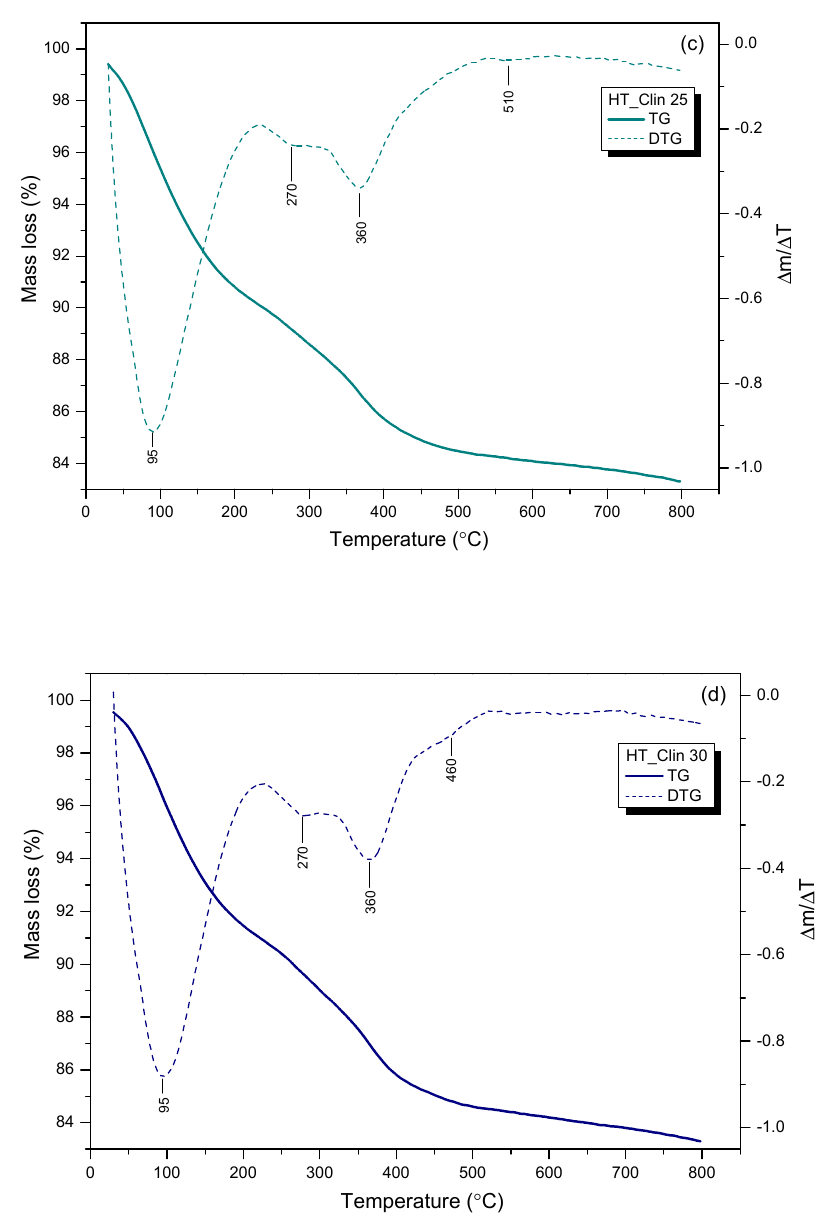
Figure 8. TGA profiles recorded for non-supported hydrotalcite ( a ) and hydrotalcite co-precipitated on the surface of clinoptilolite within 30–800 °C: HT_Clin 20 ( b ), HT_Clin 25 ( c ), HT_Clin 30 ( d ). Table 3. Approximate weight loss recorded for the materials during TG